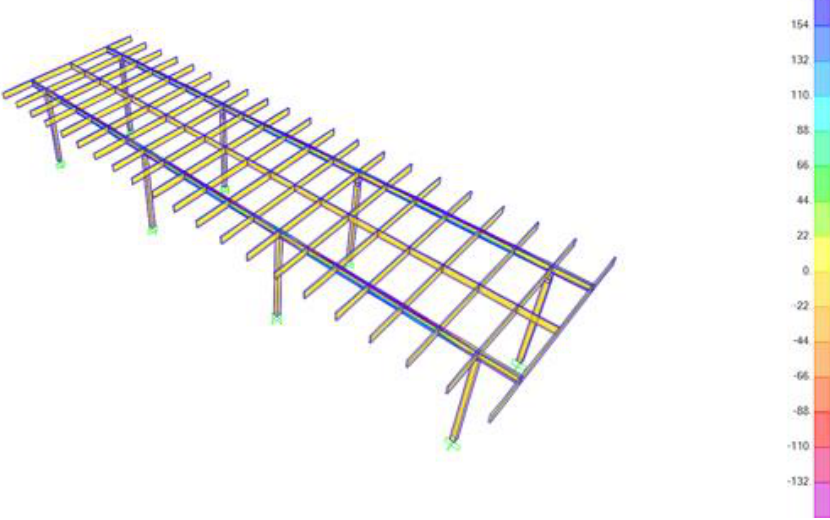
Figure A9. Double-span system stress contour in kPa using finite element analysis.